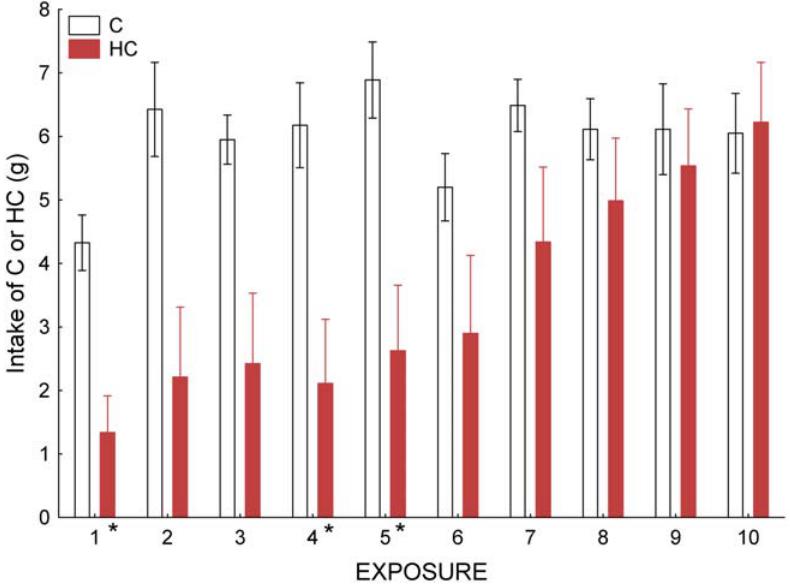
Figure 8. Mean (SE) guinea pig intake of either HC or C diets during exposure sessions. Solid rose bars show HC-exposed animals (N=8) and open bars show C-exposed animals (N=8). Asterisks indicate days for which there were significant statistical differences, correcting for multiple comparisons, between the HC- and C-exposed means.